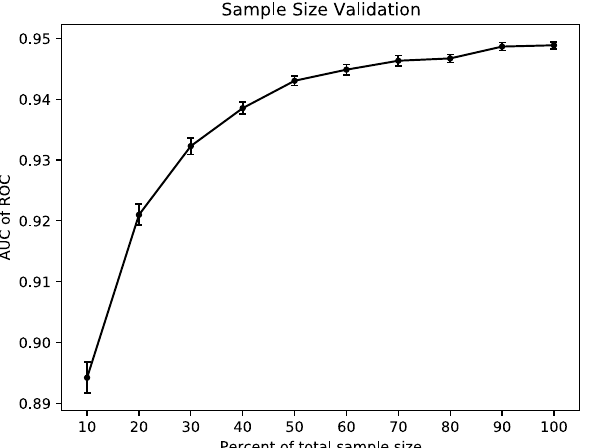
Figure 3. The impact of sample data size on model performances. AUC area under the curve, ROC operator